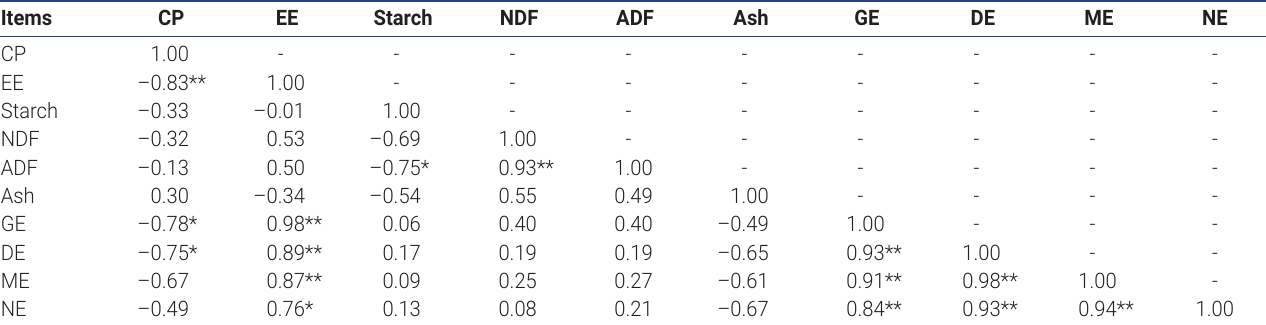
Table 6. Correlation coefficients between chemical composition and energy values of the eight rapeseed meal samples